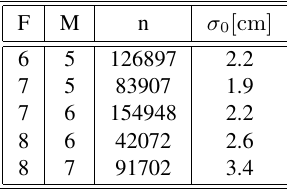
Table 1: Information about the 3D LSM runs on the five pairs of strip DSMs: identifier of the fixed (F) and moving strip (M); number (n) of points used in the entire overlap after applying the roughness mask; the root of the reference variance σ 0 of the LSM